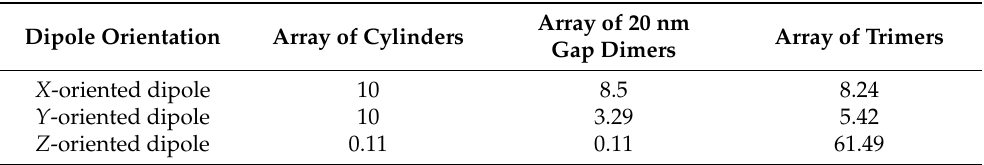
Table 1. Collection efficiency enhancement of an optical fiber with NA = 0.5. The dipole is located at the center 7 nm above the structure. X , Y , and Z orientations of the dipole are considered.